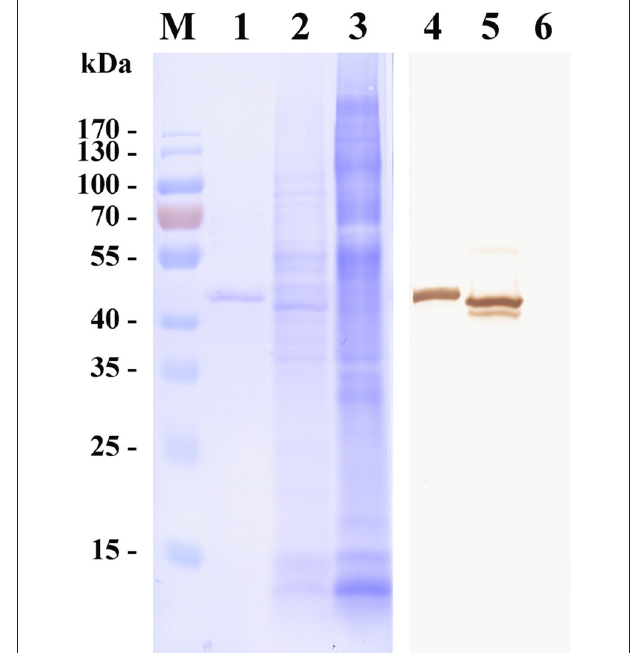
FIGURE 1 | Western blot of a surface antigen of Babesia microti merozoites (BMSA). Recombinant BMSA with a His-tag (lane 1 and 4), B. microti crude proteins (lane 2 and 5), and normal red blood cell (RBC) proteins (lane 3 and 6) were analyzed. Protein was stained with CBB R-250 (lane 1–3); Protein incubated with an anti-BMSA monoclonal antibody. The molecular mass was 43 kDa (lane